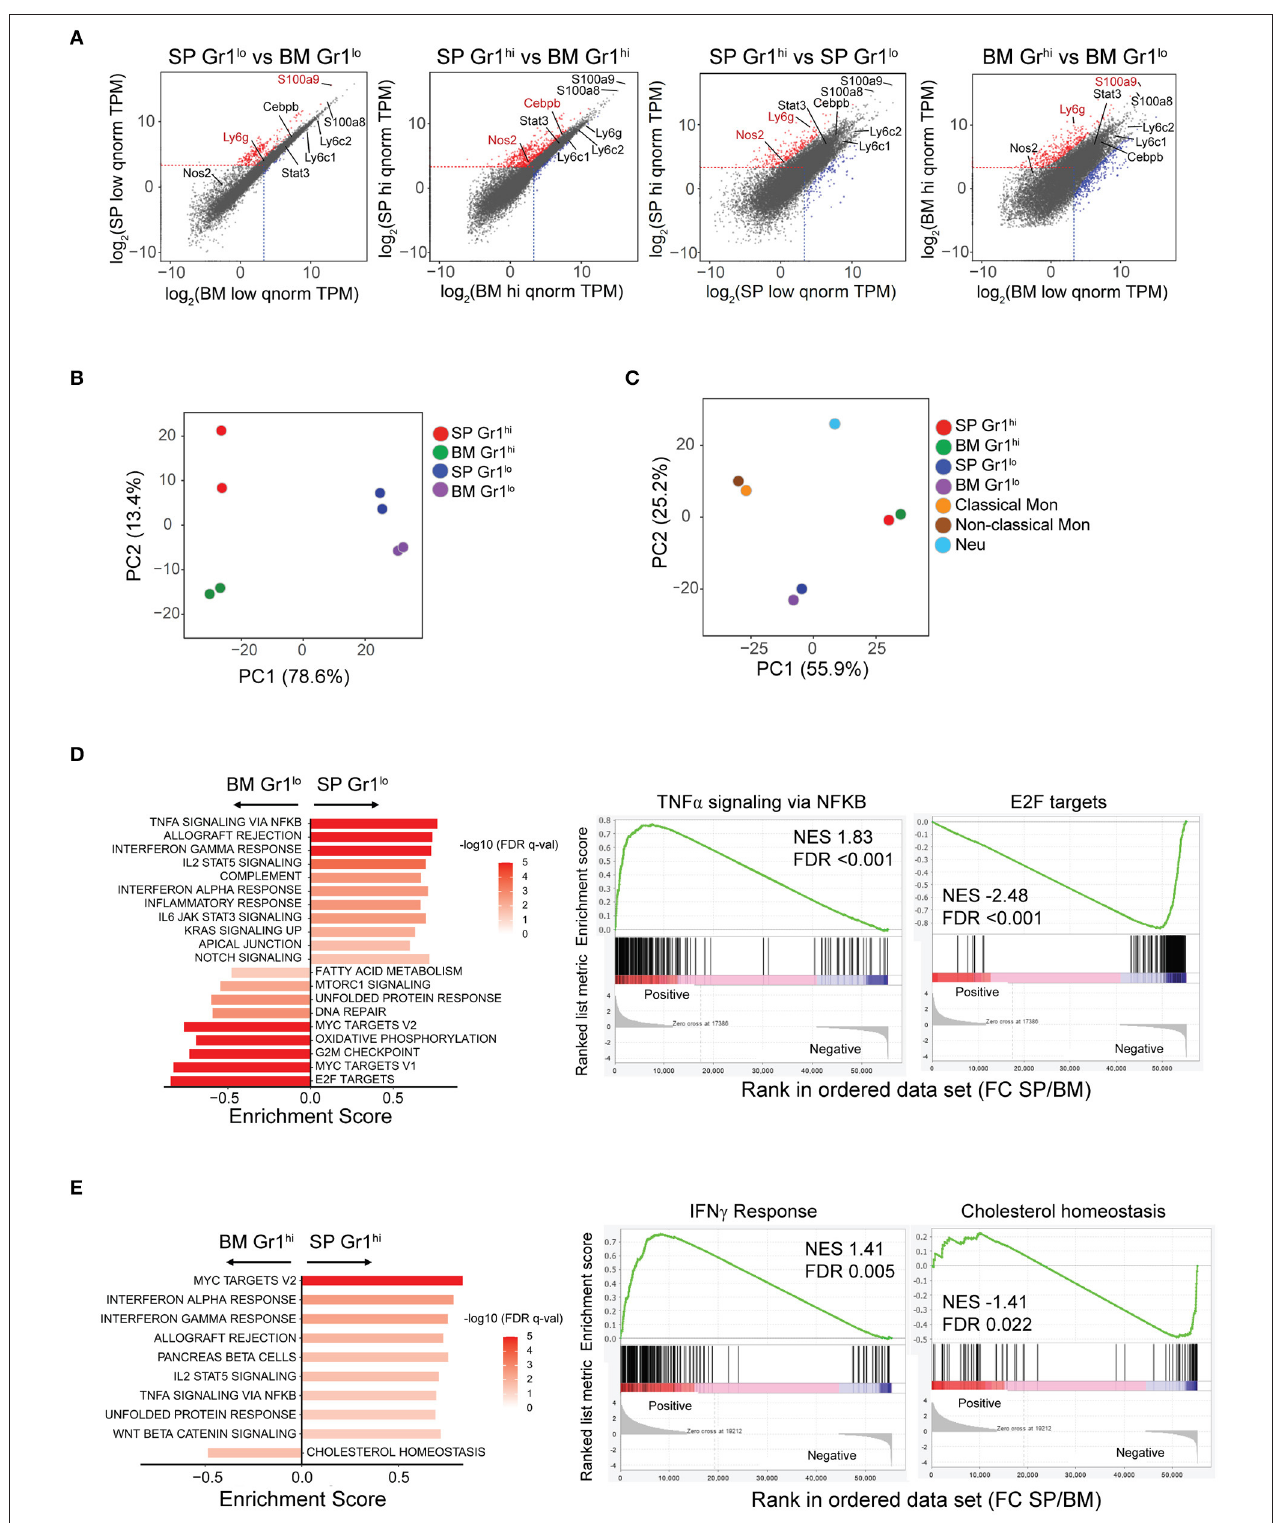
FIGURE 2 | Transcriptome profiling of SDMCs. RNA-seq analysis of CD11b + Gr-1 hi and CD11b + Gr-1 lo cells from spleen and BM of sanroque mice. (A) The transcriptomes of the 4 sorted cell populations are displayed as pairwise scatter plots. Upregulated and downregulated genes under the criteria (Log 2 FC > 1 and adjusted P < 0.05 for the left two plots; Log 2 FC > 3 and adjusted P < 0.01 for the right two plots) are displayed as red- and blue-colored dots, respectively. Signature